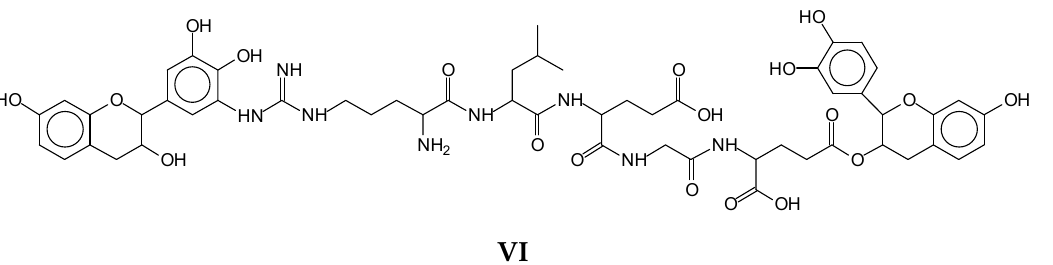
Figure 9 . Example of a species ( VI ) of the same molecular weight of species V in which the peptide chain oligomer is linked to two flavonoid monomer units of tannin oligomers, showing the possibilities of cross-linking of the adhesive system.